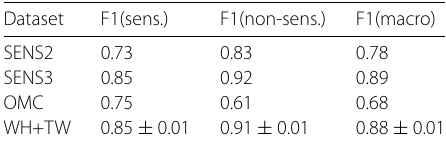
Table 17 Detailed classification results (F1-score) using BERT. Results on WH+TW are averaged on ten